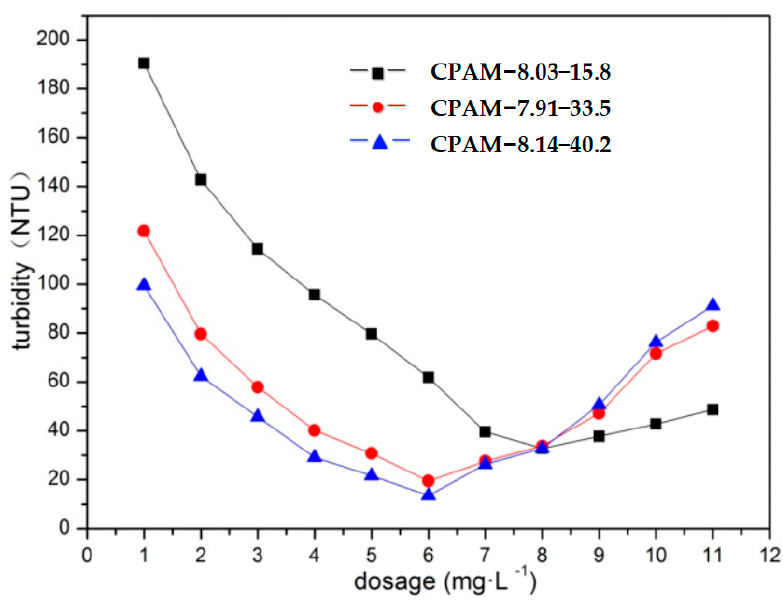
Figure 4. Impact of dosage and cationic degree of CPAM on its flocculation effect.